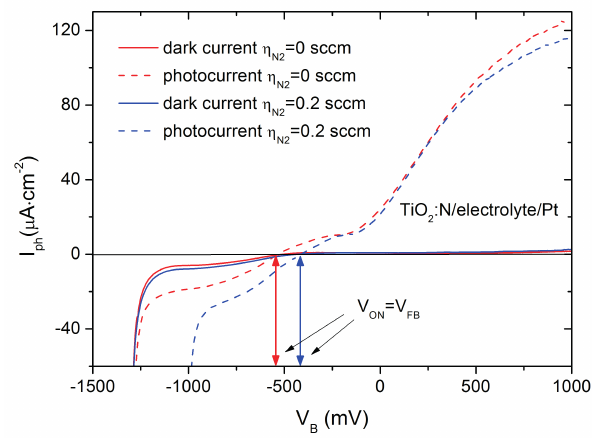
(V ) characteristics of pure and nitrogen ph B